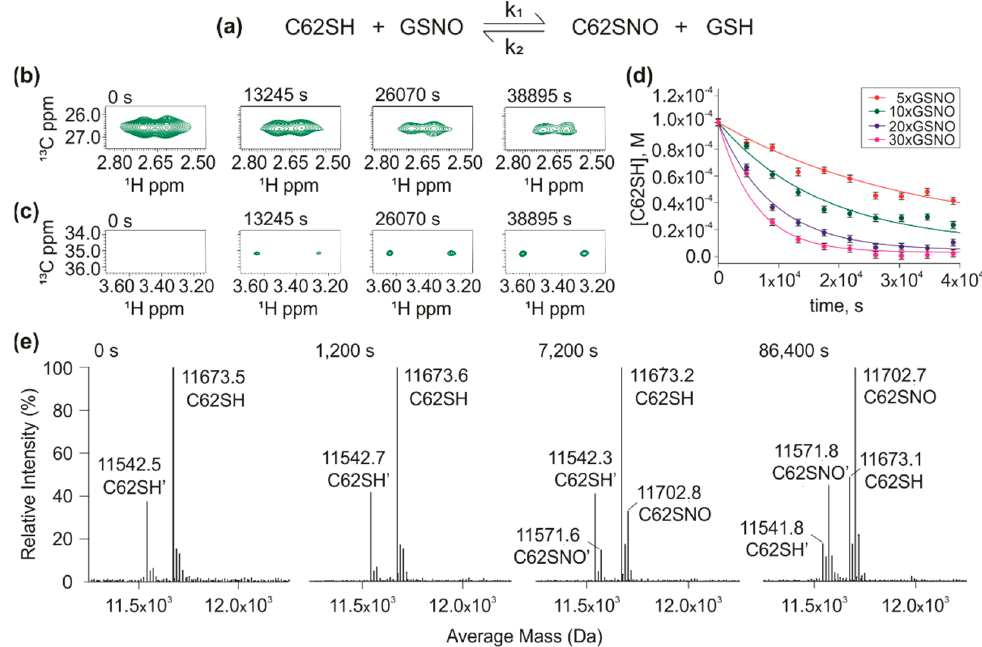
Figure 1. S-nitrosation kinetic of C62only (C62SH): ( a ) The reaction between C62SH mutant and GSNO; ( b ) 1 H- 13 C HSQC of C62SH (100 µM) and 10× of GSNO reaction at different reaction times, as an example. They show H β /C β cross-peak of C62SH intensity decreasing over time; ( c ) At the same time, the 1 H- 13 C HSQC shows the H β /C β cross-peak of C62SNO intensity increasing over time; ( d ) Global fitting of kinetic data calculated based on H β /C β cross-peak of C62SH. The curves correspond to different reaction conditions: 5 (500 µM-red), 10 (1000 µM-green), 20 (2000 µM-blue) and 30 times of GSNO (3000 µM-magenta). Rate forward constant (k 1 ) calculated for the C62SH S-nitrosation reaction was 5.3 ± 0.2 × 10 − 2 M − 1 s − 1 , reverse one (k 2 ) was 5.1 ± 2.4 × 10 − 2 M − 1 s − 1 ; ( e ) Mass Spectra of reaction between C62SH (100 µM) and 10x of GSNO acquired in different reaction times (0 s, 1200 s, 7200 s, and 86,400 s). C62SH without first Met is shown as C62SH’. C62SNO and C62SNO’ are S-nitrosated species. The experimental error for each experimental point in D was estimated from the standard deviation of the spectral noise for one experiment.